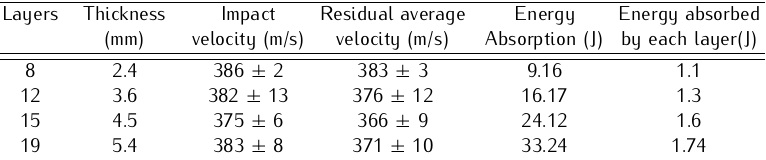
Table 4. Initial and residual velocities for laminates of 0/90/45/-45 lay-up sequence.